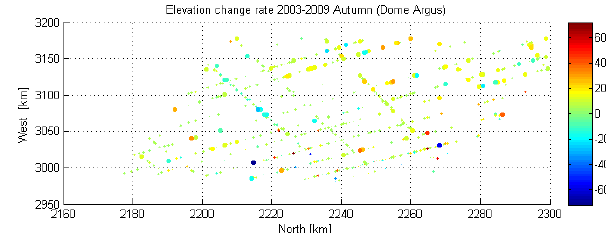
Figure 6. Plots of estimated elevation change rates (in cm/y) in the area of Dome